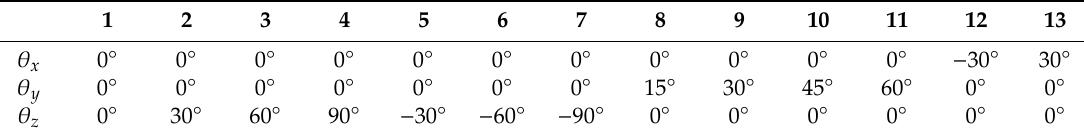
Table 2. The 3D attitude of F35 model in scene